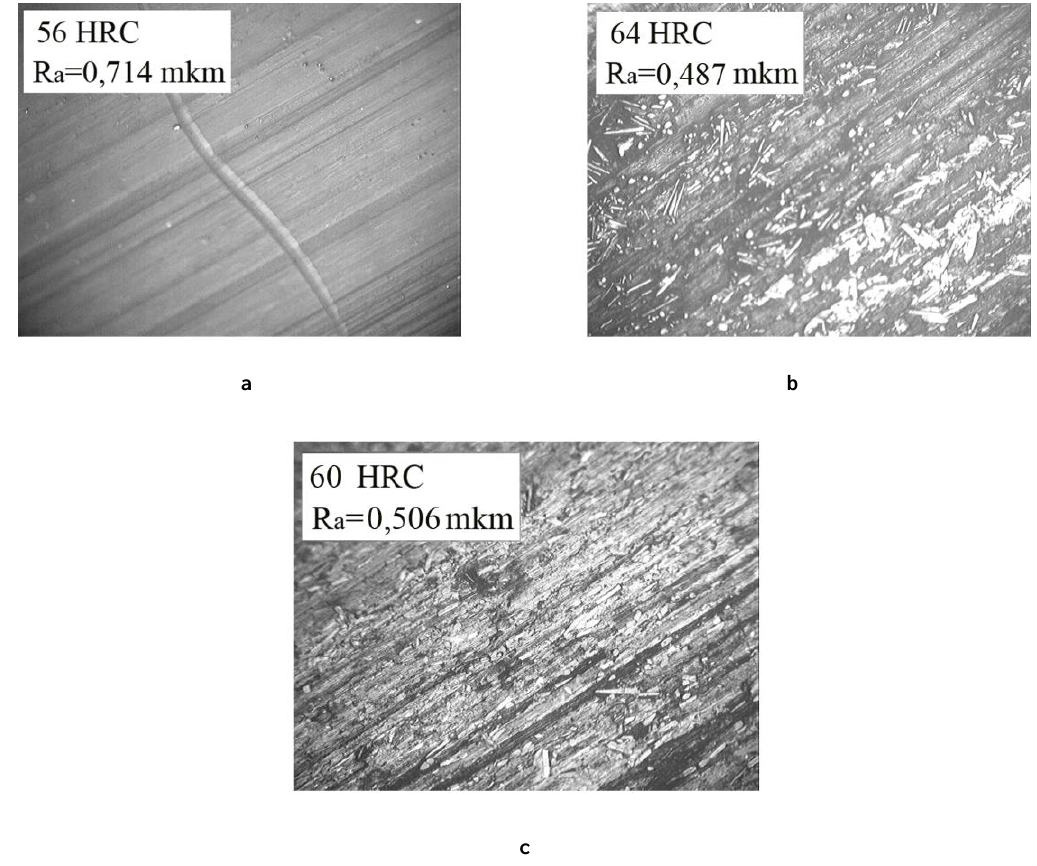
Fig. 4. Microstructure (× 100) of the friction surface during wear of polyethylene terephthalate (a) and basaltoplastics based on reinforced with 5 (b) and 10 (c) mass.% of fibers (specific load P = 1 MPa, sliding speed υ = 1